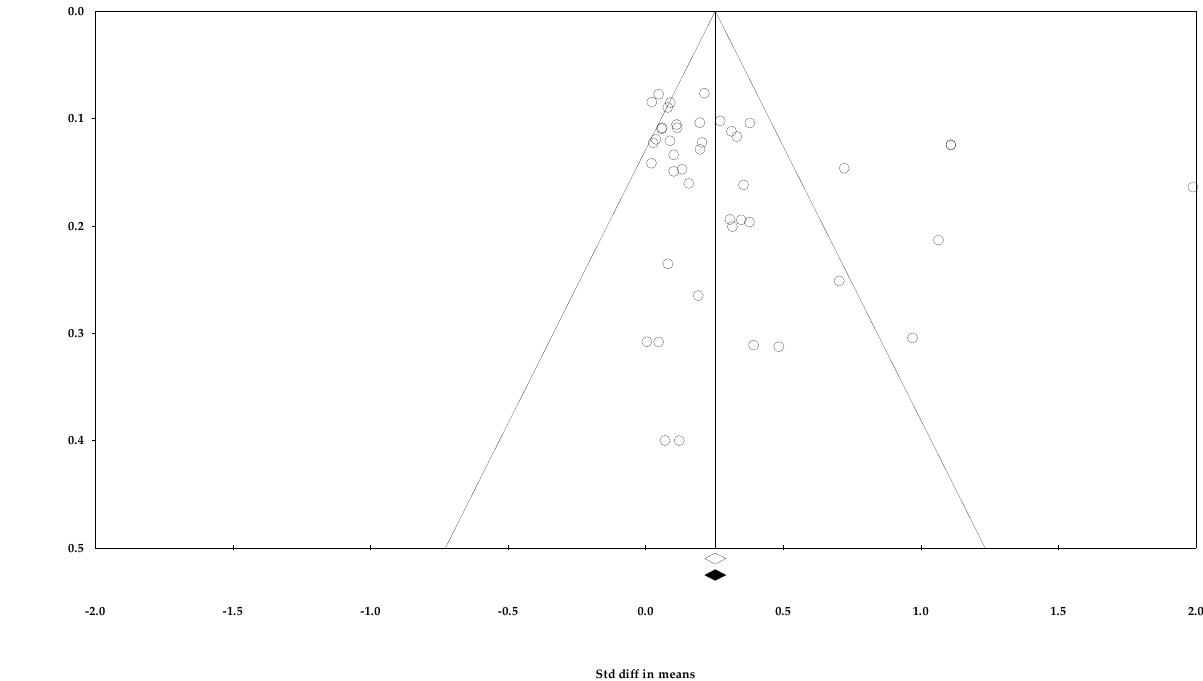
Figure 3. A funnel plot of standardized mean difference in diastolic blood pressure. Note: summary effect size ( ◇ ), sum- mary effect size of imputed studies ( ◆ ), individual study ( ○